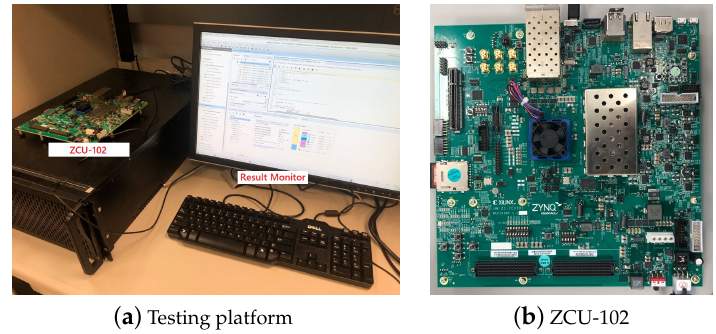
Figure 12. Configuration of the testing environment.